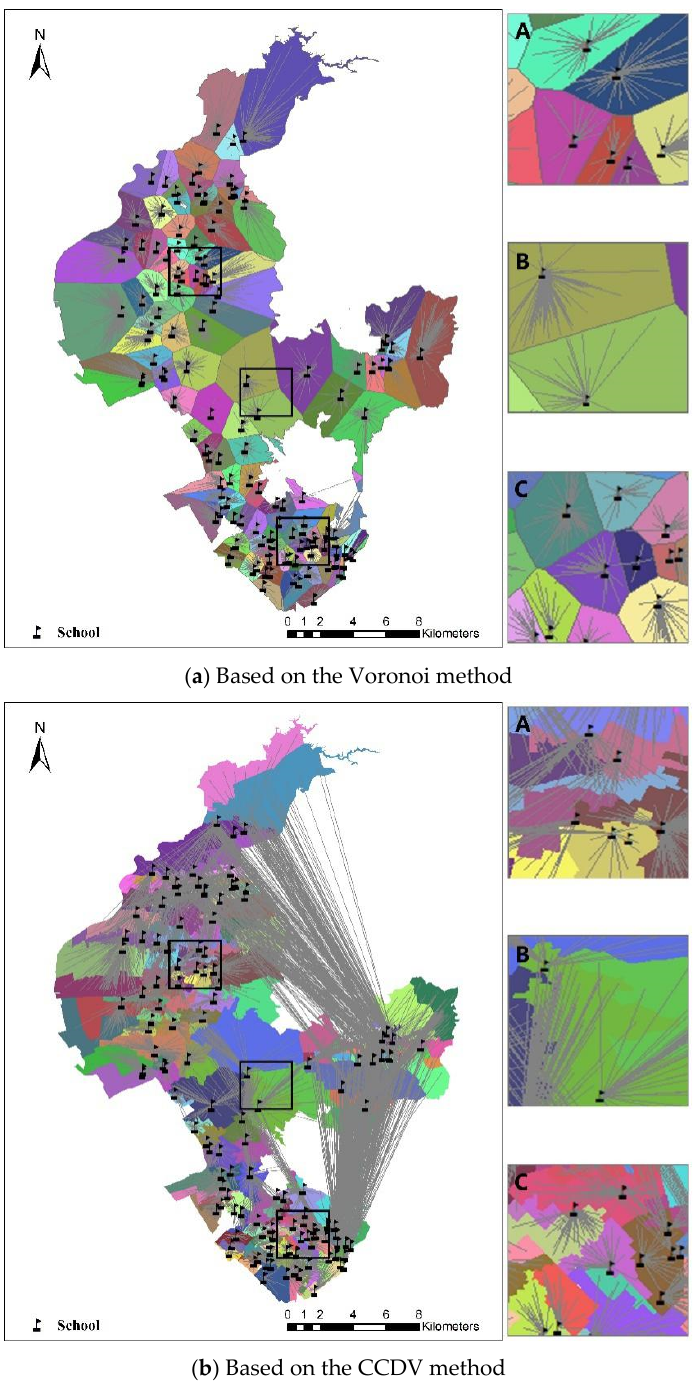
Figure 5. Correspondence between schools and school ‐ age children in the community unit.